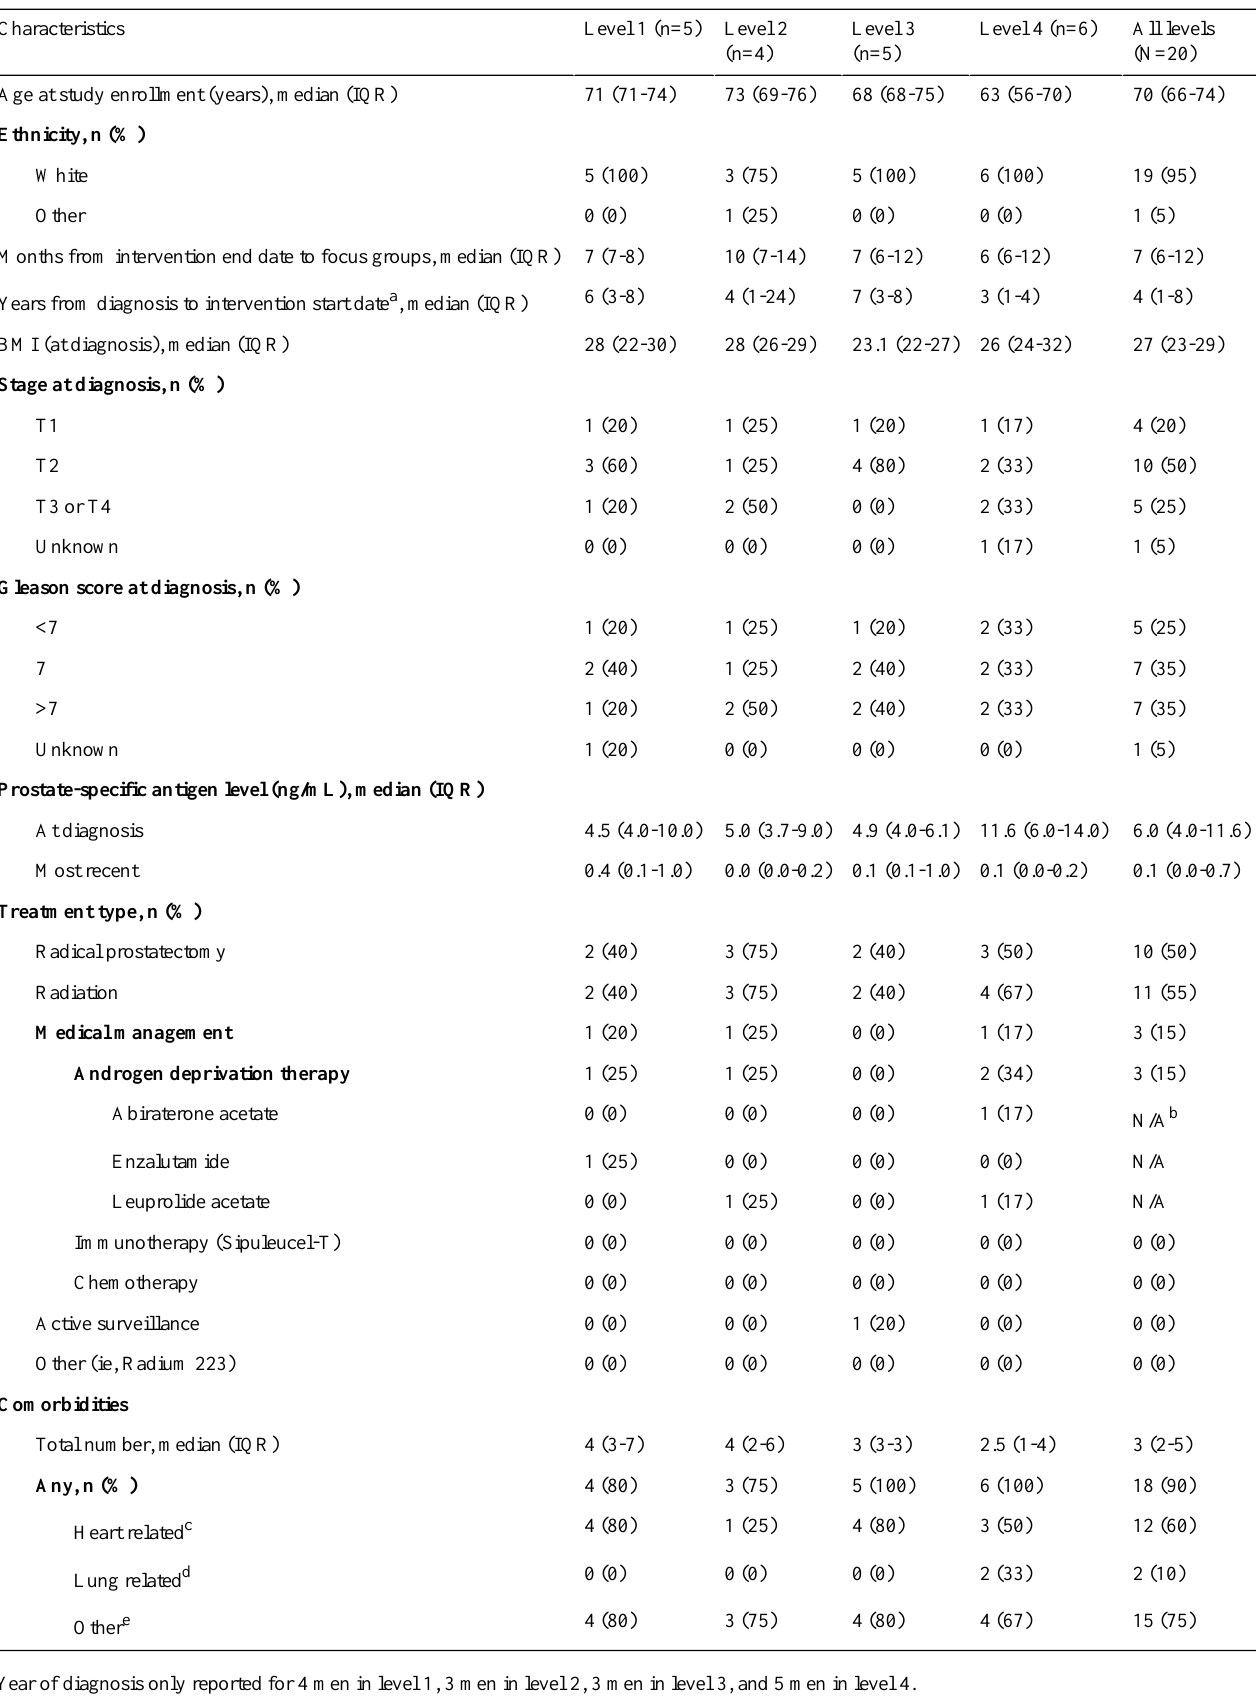
Table 1. Self-reported characteristics of 20 men with prostate cancer who participated in a 12-week remotely delivered lifestyle intervention and volunteered for a postintervention focus